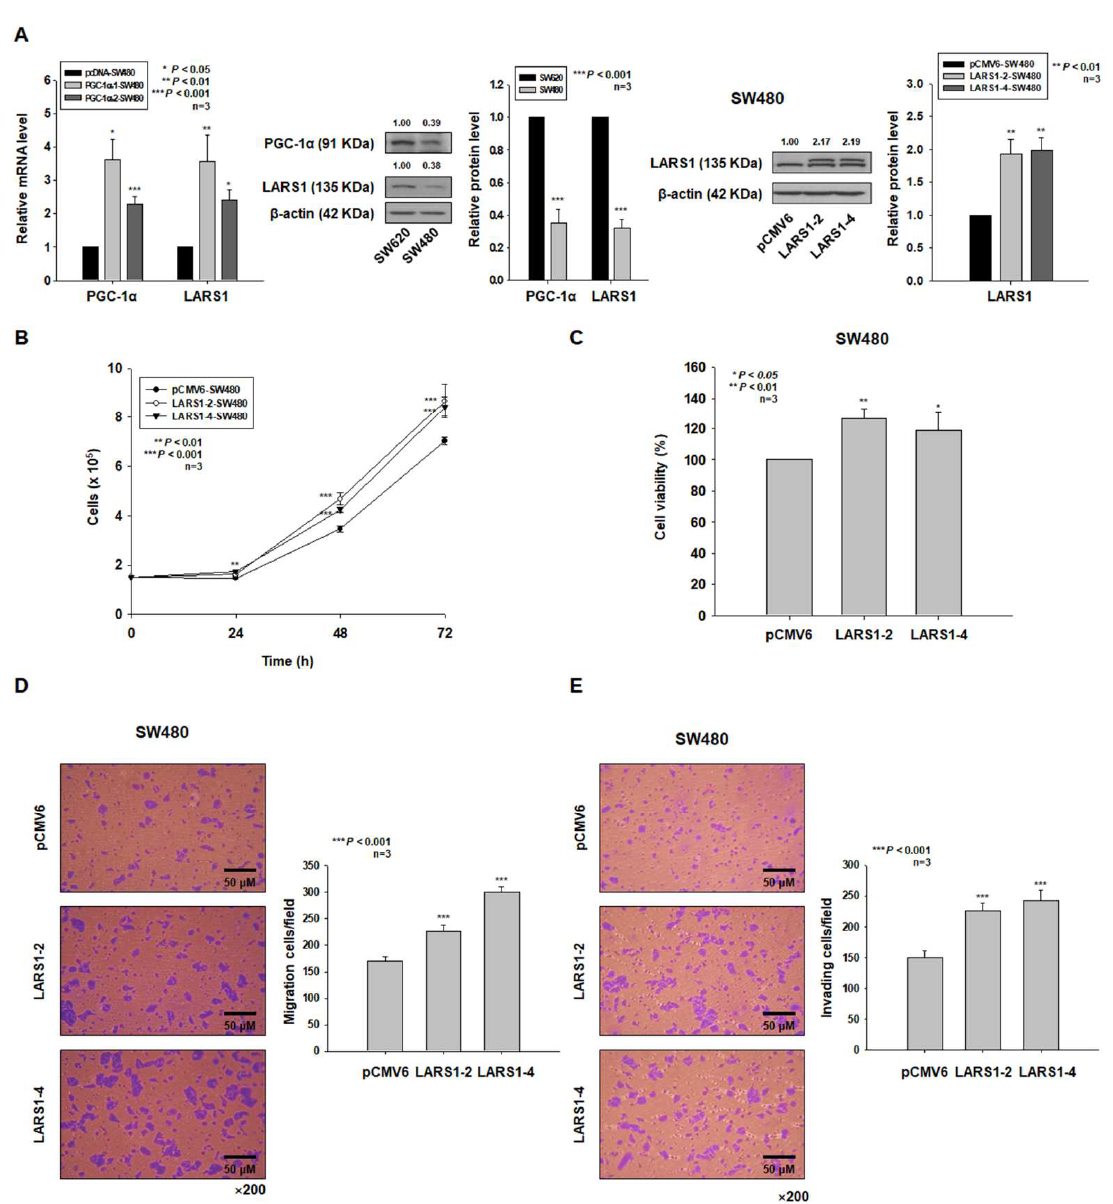
Figure 2. LARS1 overexpression enhances cell proliferation, migration, and invasion of SW480 cells. ( A ) Left panel: Expression levels of PGC-1α and LARS1 mRNA in pcDNA-, PGC-1α-1-, or -2-SW480 cells. Middle panel: Expression of PGC-1α and LARS1 in SW620 and SW480 cells. Right panel: SW480 cells were transfected with LARS1 or pCMV6 expression vector and screened based on their resistance to G418 (800 μg/mL). Western blot was used to detect PGC-1α and LARS1. β-actin was used as an internal control. Densitometry results are indicated above bands. Representative data of three independent experiments are shown. Data are expressed as the mean ± SD of three independent experiments. *** p < 0.001 vs. pcDNA-SW480 cells. ( B , C ) pCMV6-, LARS1-2, or -4-SW480 cells were seeded and cultured for the indicated times and cell proliferation was determined by cell counting ( B ) and MTT assay ( C ). Data are presented as the mean ± SD of three separate experiments. * p < 0.05, ** p < 0.01, *** p < 0.001 vs. pCMV6-SW480 cells. ( D , E ) Left panel: Representative figures of pCMV6-, LARS1-2-, and -4-SW480 cells in the transwell migration assay ( D ) and transwell invasion assay ( E ) are shown ( × 200 magnification). Right panel: The numbers of transmembrane migrated